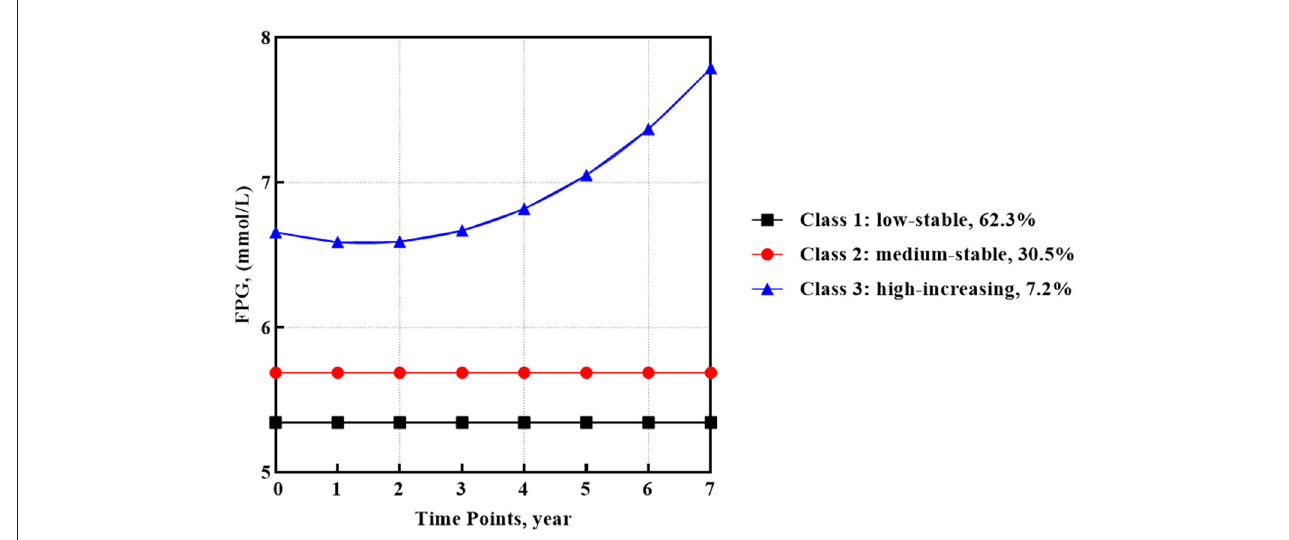
FIGURE1 FPG trajectories after HAART initiation identified by GMM ( n = 1,572).